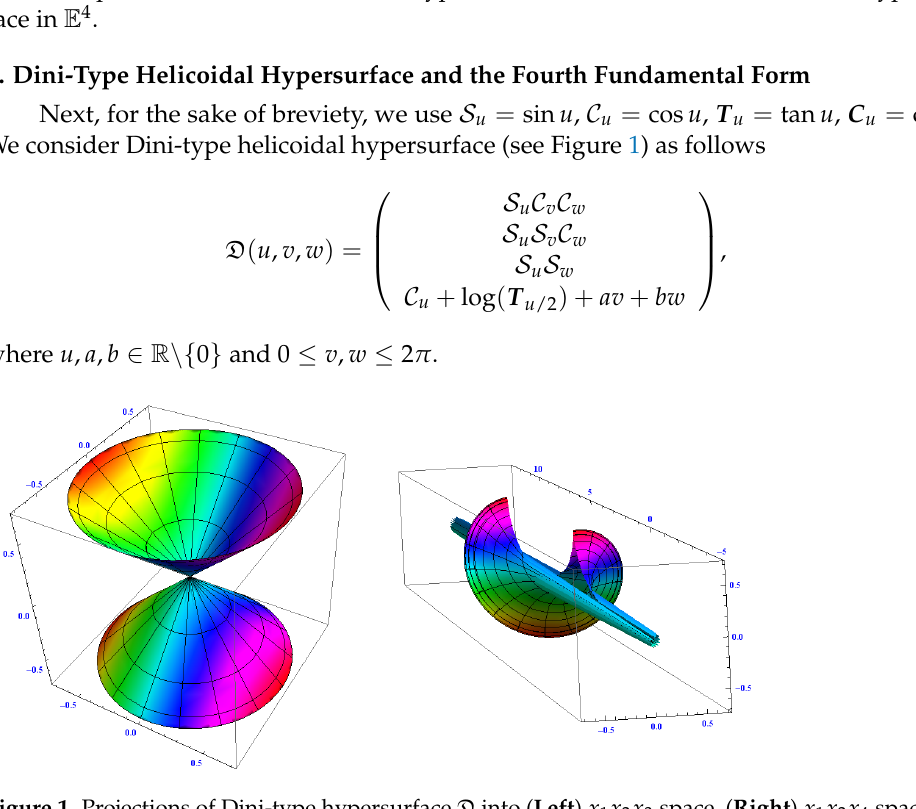
Figure 1. Projections of Dini-type hypersurface D into ( Left ) x 1 x 2 x 3 space, ( Right ) x 1 x 2 x 4